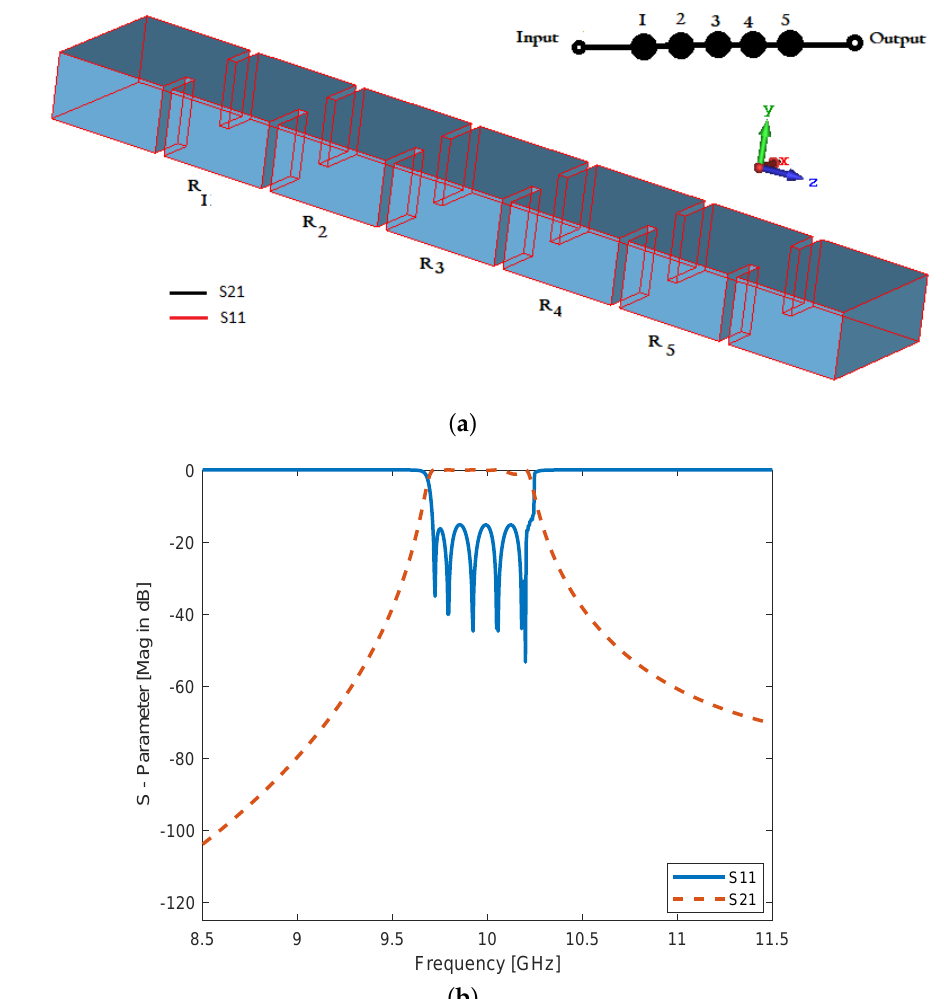
Figure 18. ( a ) conventional Bandpass waveguide filter with inductive irises fifth order N = 5 for WR- 90 standard, a > b , a = 22.86 mm, b = 10.16 mm, and ( b ) illustration of S-parameters S11 and